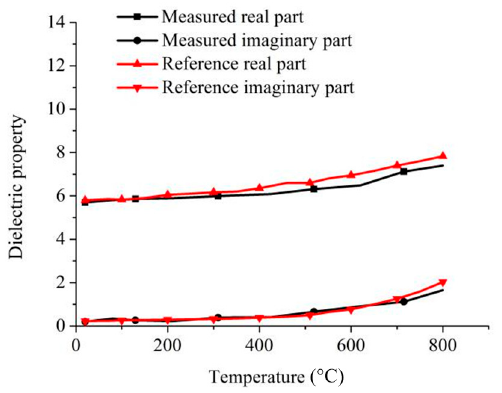
Figure 8. Comparison of measured and reference relative complex permittivity of Macor.